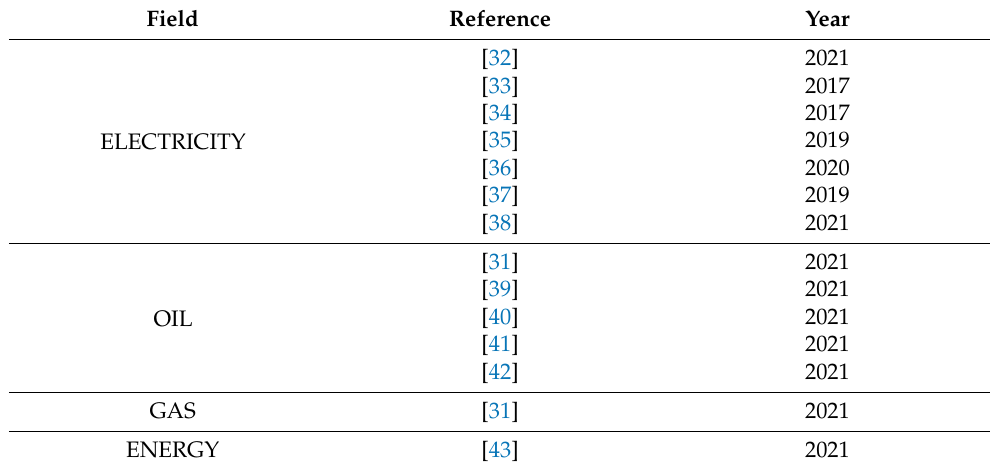
Table 2. Articles found by fields and